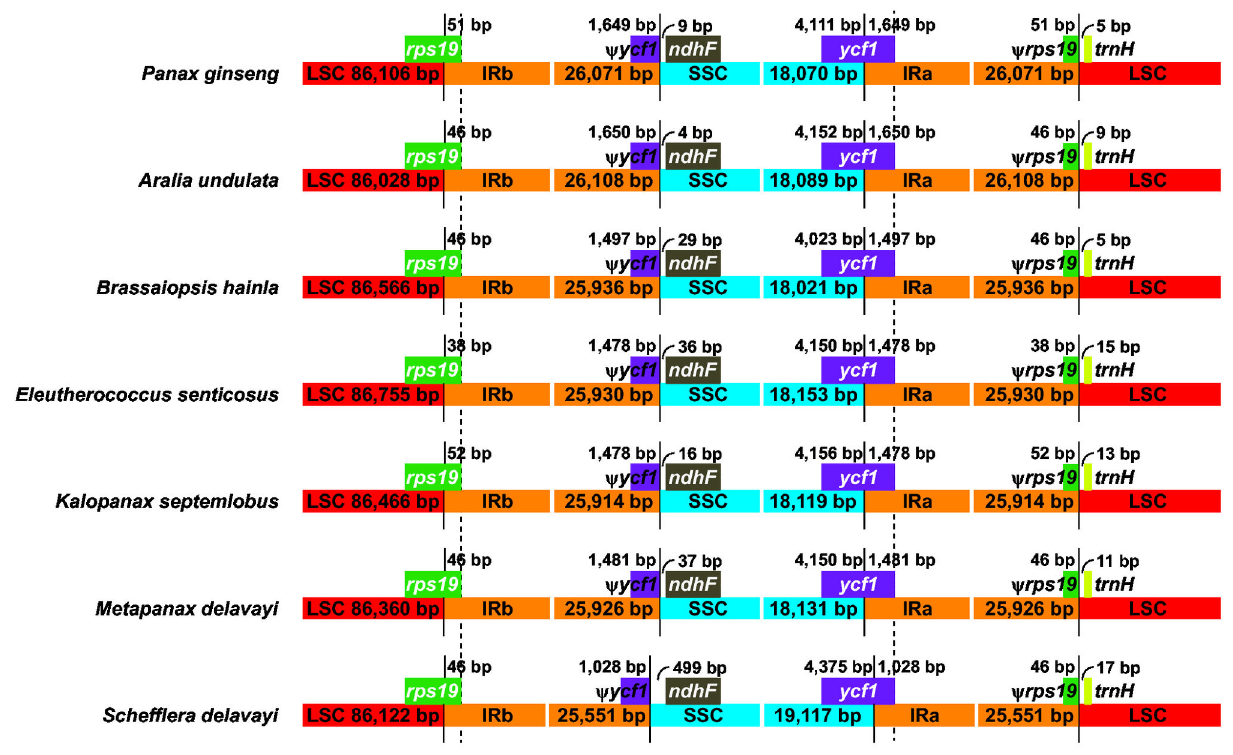
Figure 3. Comparison of border positions of LSC, SSC, and IR regions among seven Araliaceae chloroplast genomes. Boxes above the main line indicate the genes while the pseudogenes at the borders are shown by Ψ. The figure is not the scale and just shows relative changes at or near the IR/SC